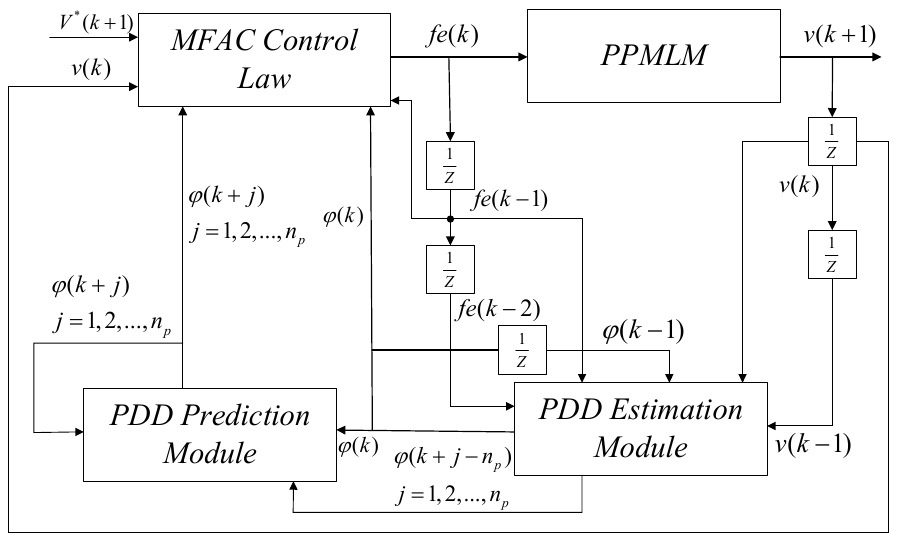
Figure 3. Structure diagram of the control algorithm based on CFDL−MFAPC.